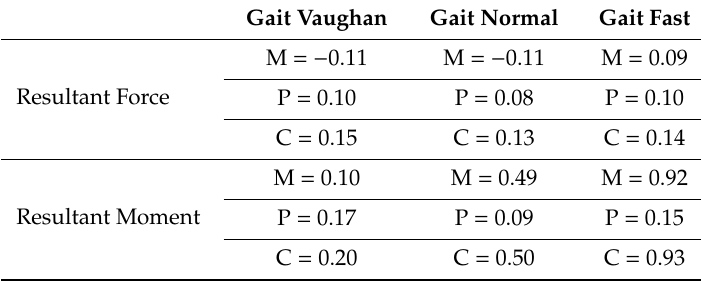
Table 1. Geers metric applied for resultant force and moment: in silico vs. in vivo.